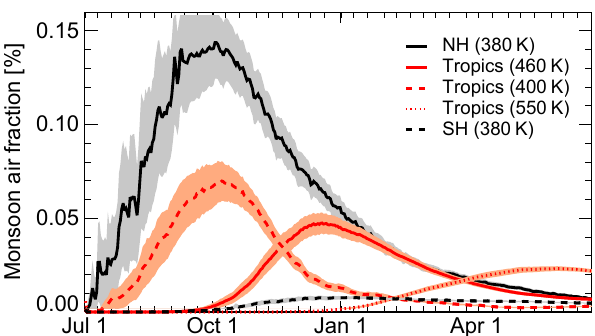
Figure 2. Climatological time series of monsoon air mass fraction in the tropical lower stratosphere (15 ◦ S–15 ◦ N) at 460K (red solid), 400K (red dashed), and 550K (red dotted), and in the extratropical lower stratosphere (50–70 ◦ N/S) at 380K in the NH (black solid) and in the SH (black dashed). Shading shows the mean standard deviation for the zonal average (multiplied by 0.25 for better vis- ibility), as a measure of geographic variability in the midlatitude tracer